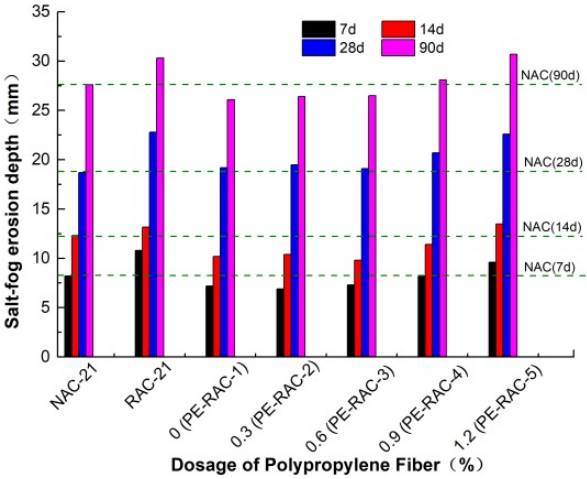
Figure 5. Salt spray erosion depth under different waste fiber content.